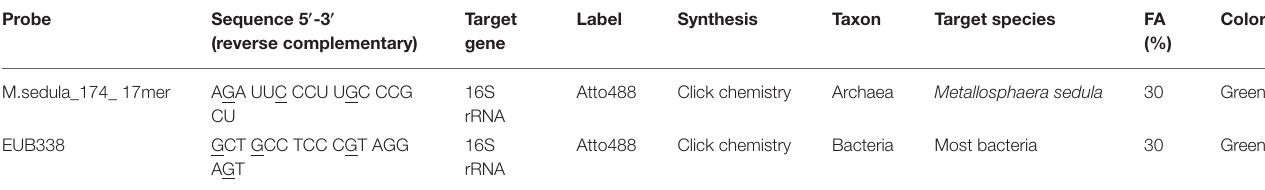
TABLE 1 | Oligonucleotide probe used in this